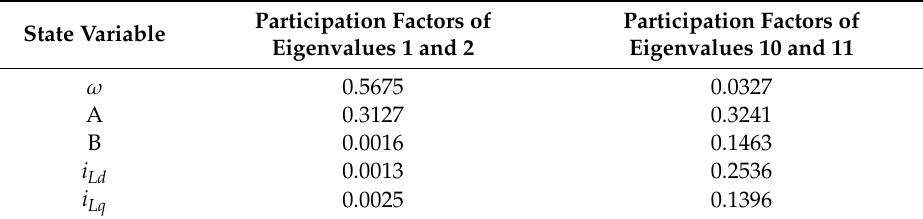
Table 3. Participation factors of the dominant